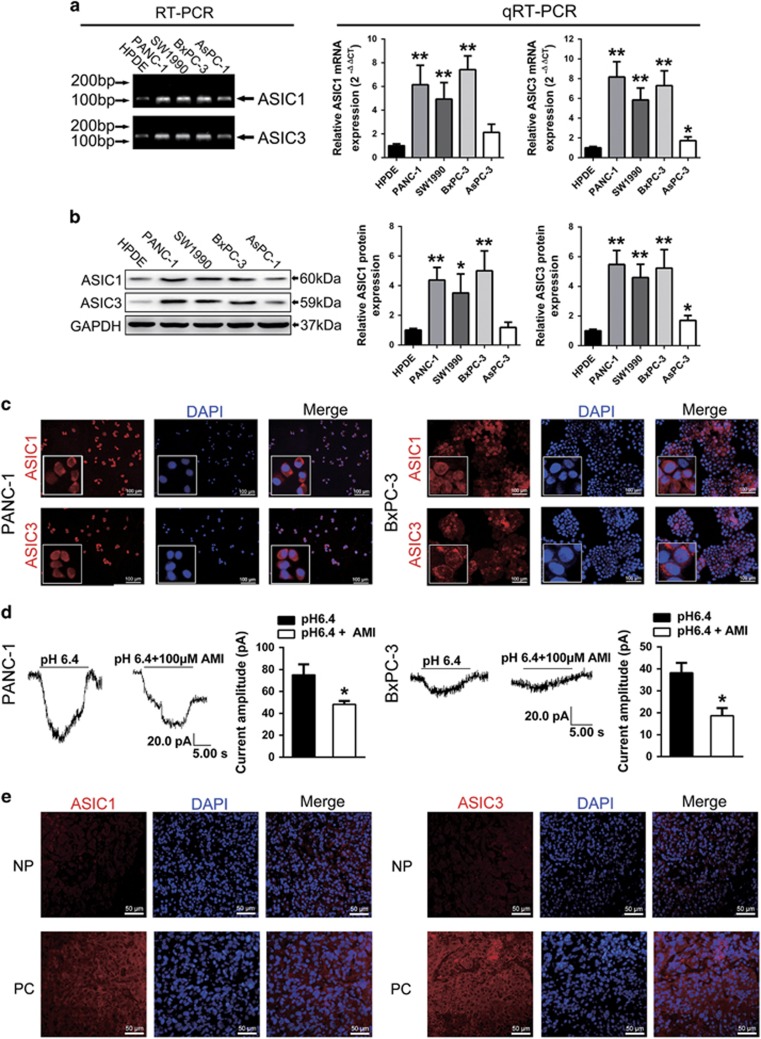
ASIC1 and ASIC3 are functionally expressed in pancreatic cancer. (a and b) The mRNA and protein expression of ASIC1 and ASIC3 in four pancreatic cancer cell lines (PANC-1, SW1990, BxPC-3 and AsPC-1) and normal pancreatic ductal cells (HPDE) were measured by RT-PCR, qRT-PCR and western blot. Values were normalized against HPDE from three experiments performed in triplicate and were presented as means±S.D. (*P<0.05; **P<0.01). (c) Representative immunofluorescence of ASIC1 and ASIC3 in PANC-1 and BxPC-3 cells. (d) Whole-cell current of PANC-1 and BxPC-3 incubated with acidic (pH 6.4) extracellular solution was recorded by whole-cell voltage-clamp recording. After cells were treated with amiloride, whole-cell current was recorded again. (e) Representative immunofluorescence of ASIC1 and ASIC3 in pancreatic cancer (PC) tissues and its paired adjacent noncancerous pancreatic (NP) tissues from patients